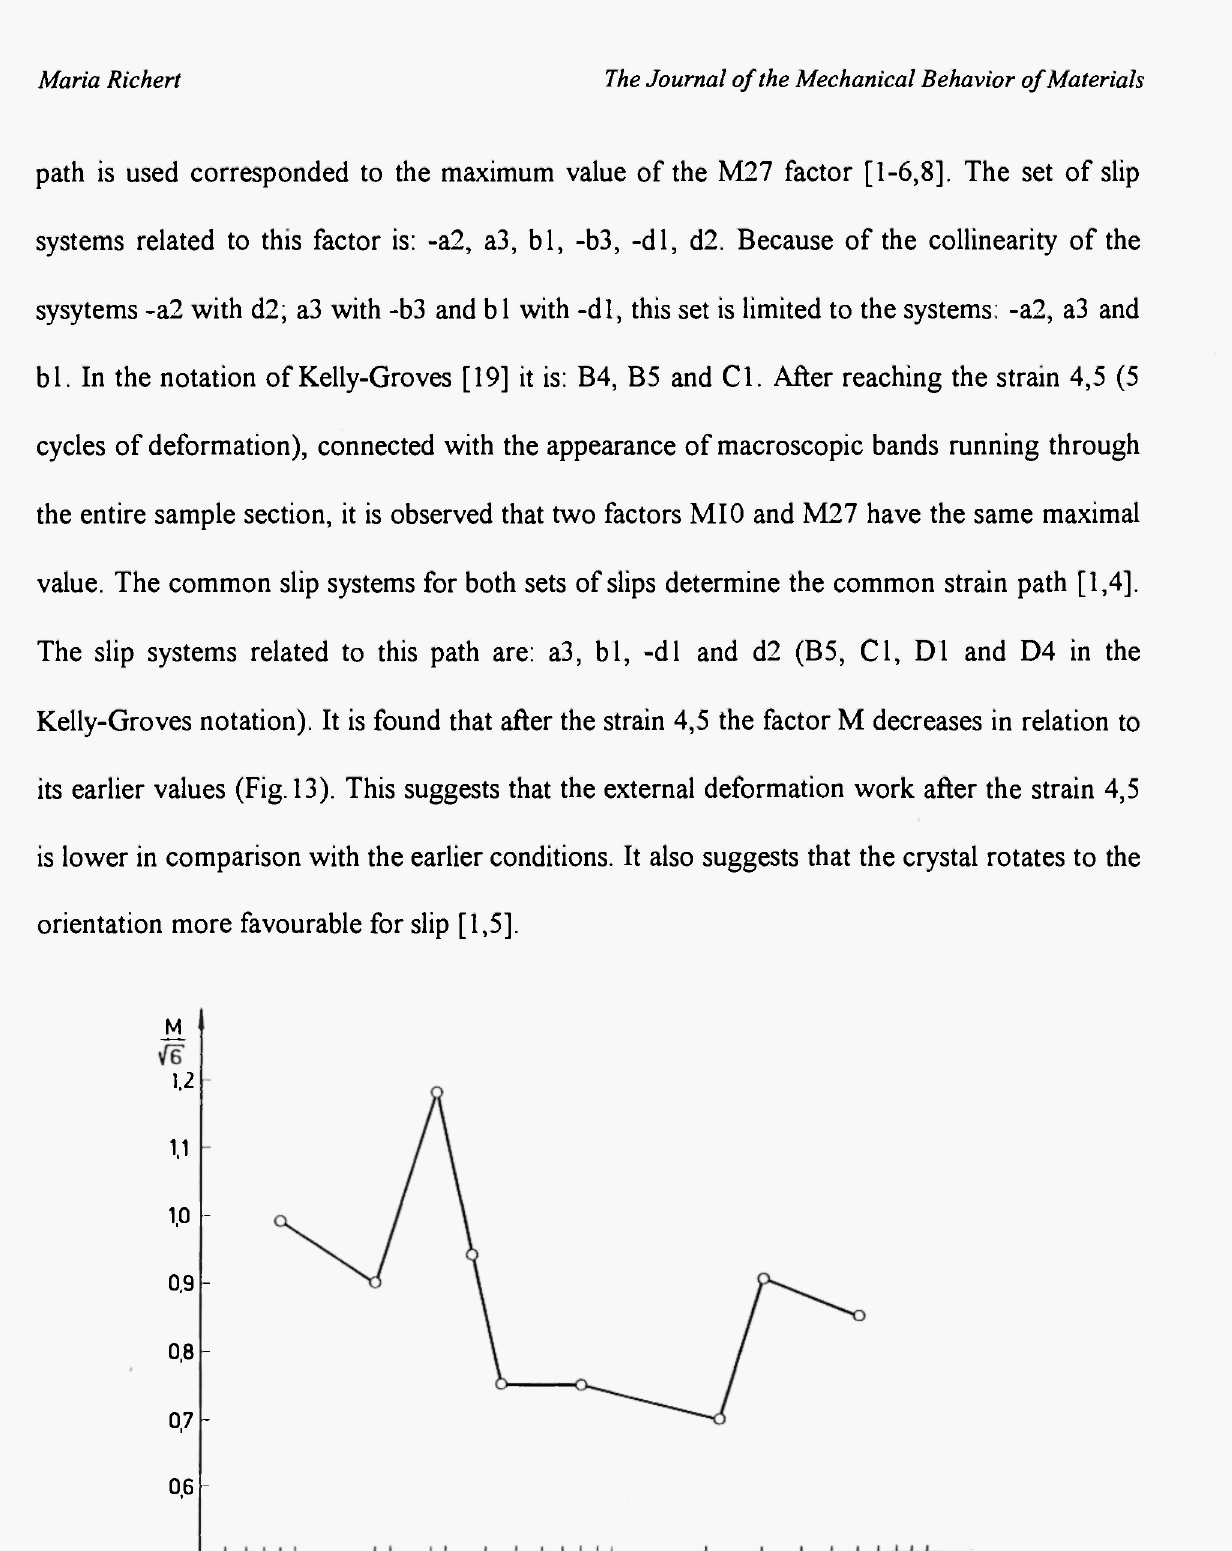
Fig. 13. The changes of orientation factor Μ versus the cumulate deformation φ in the CEC